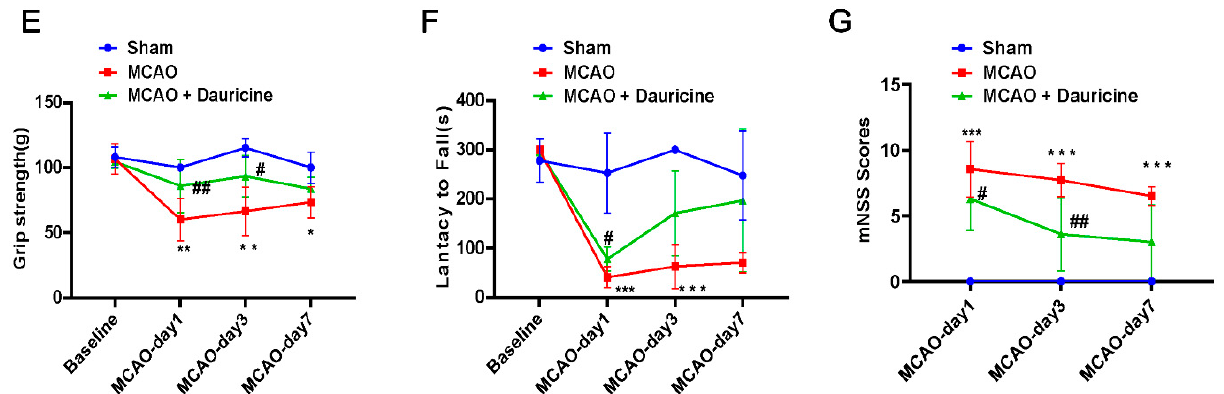
Figure 2. Dauricine improved the tMCAO injury. ( A ) The diagram of the animal studies with the experimental design timeline. ( B ) The cerebral blood flow after MCAO, anatomy and infrared images are showed above, while the quantitative figure is showed below. ( C ) Mouse brains were procured at day 7 after ischemia-reperfusion, and the infarct volume was determined by TTC staining and quantified ( D ) (* p < 0.05). The functional outcomes of the tMCAO mice were evaluated by grip strength ( E ), Lantacy to fall ( F ), and mNSS scores ( G ). n = 10 mice per group, Sham group vs. MCAO group, ** p < 0.01, *** p < 0.001, MCAO group vs. (MCAO + Dauricine) group # p < 0.05, ## p < 0.01, two-way ANOVA with Bonferroni post hoc test.